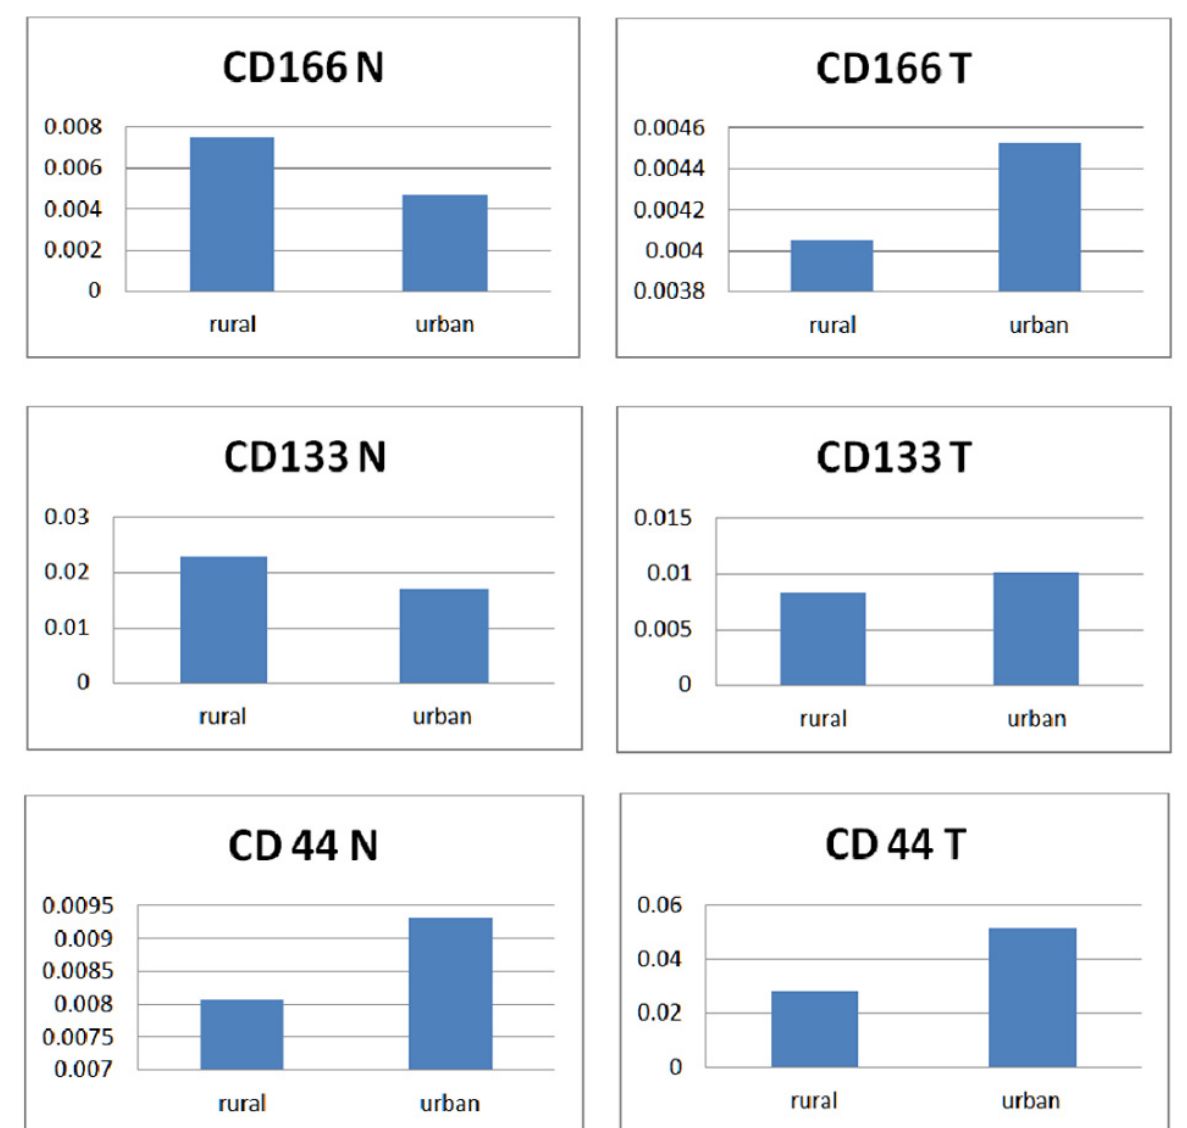
Figure 5. Normal versus tumor tissue expression of the three markers according to home location.